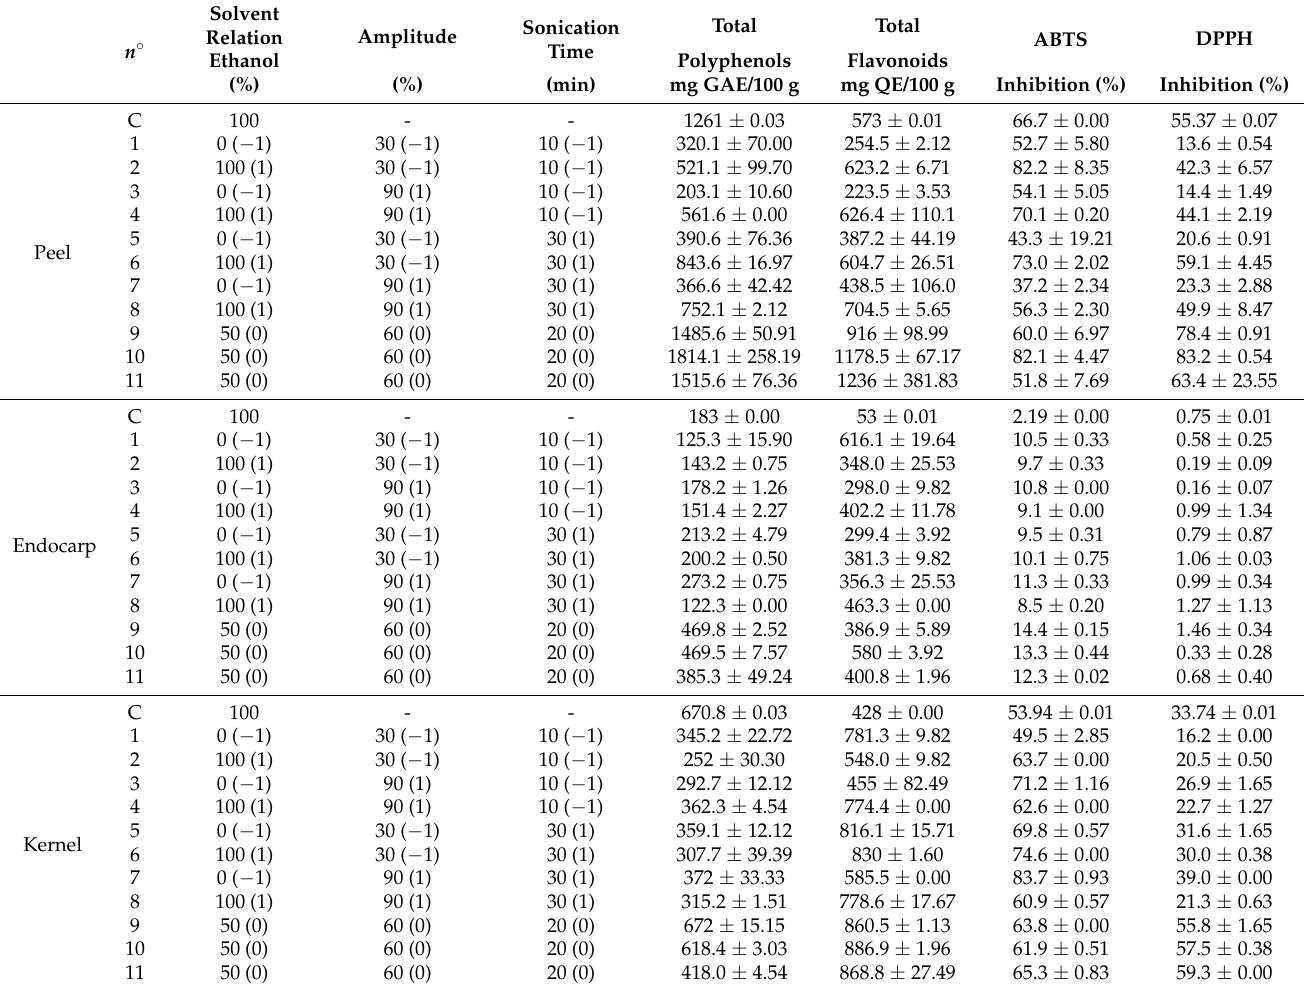
Table 1. Quantification of bioactive compounds and antioxidant activities in mango